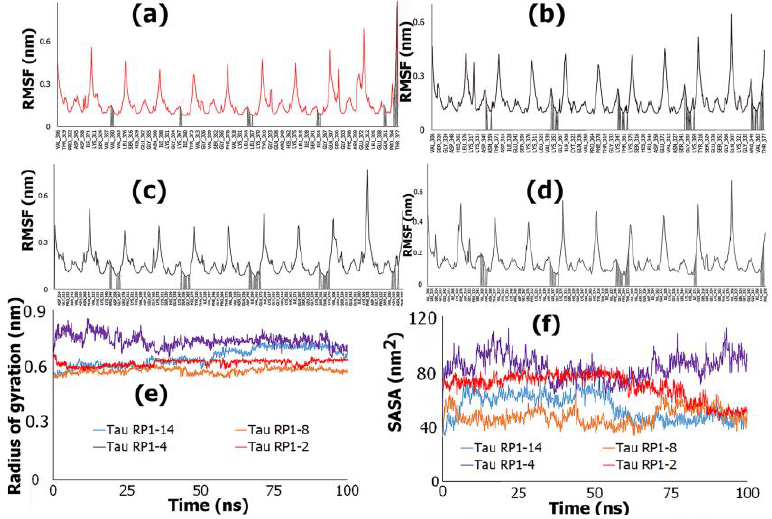
Figure 7. Comparison of RMSFs of the PHF Tau backbone upon binding with ( a ) TauRP1-2; ( b ) TauRP1-4; ( c ) TauRP1-8; ( d ) TauRP1-14. (Vertical lines show regions of interactions with PHF Tau.) ( e ) Comparison of radius of gyration of the selected four TauRP peptides upon binding with PHF Tau over 100 ns simulation. ( f ) Comparison of SASA values of the selected four TauRP peptides upon binding with PHF Tau over 100 ns